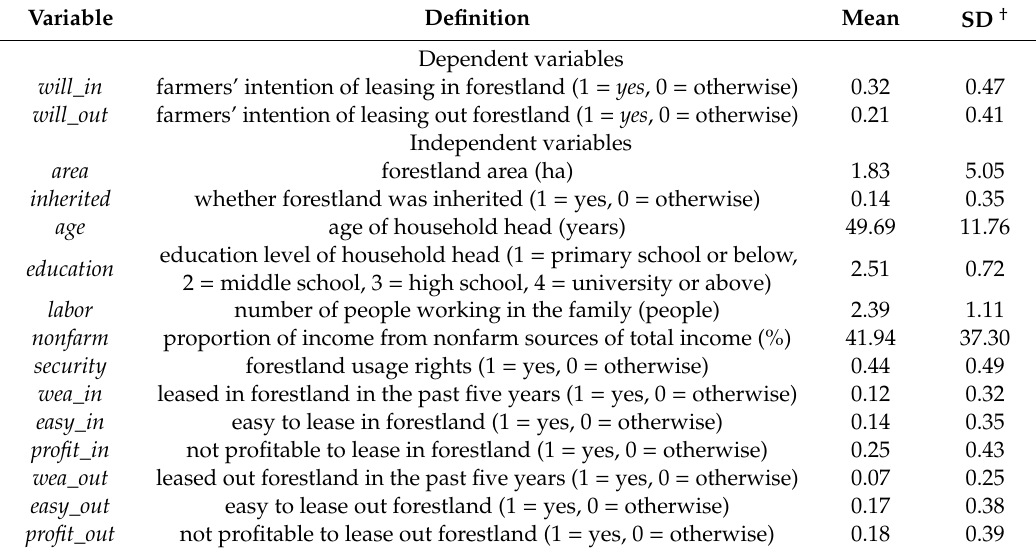
Table 2. Descriptive statistics of the